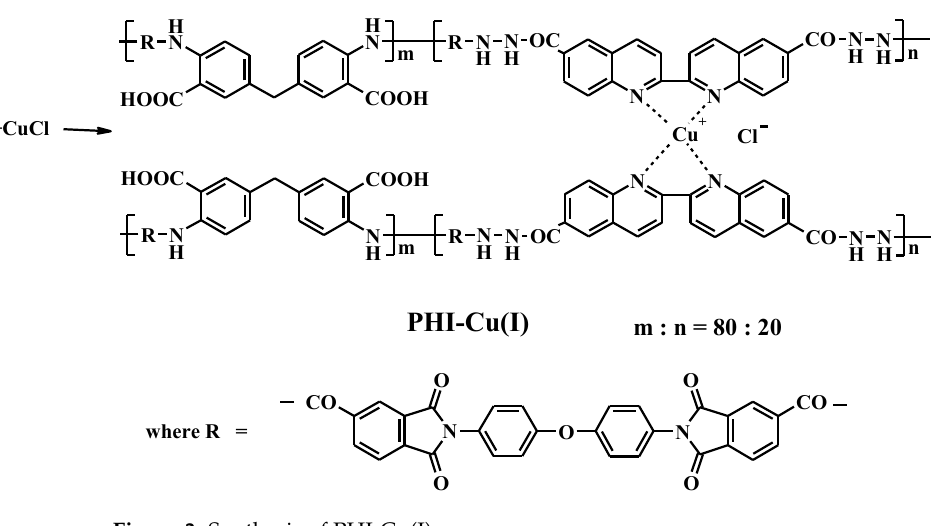
Figure 3. Synthesis of PHI- Сu(I).